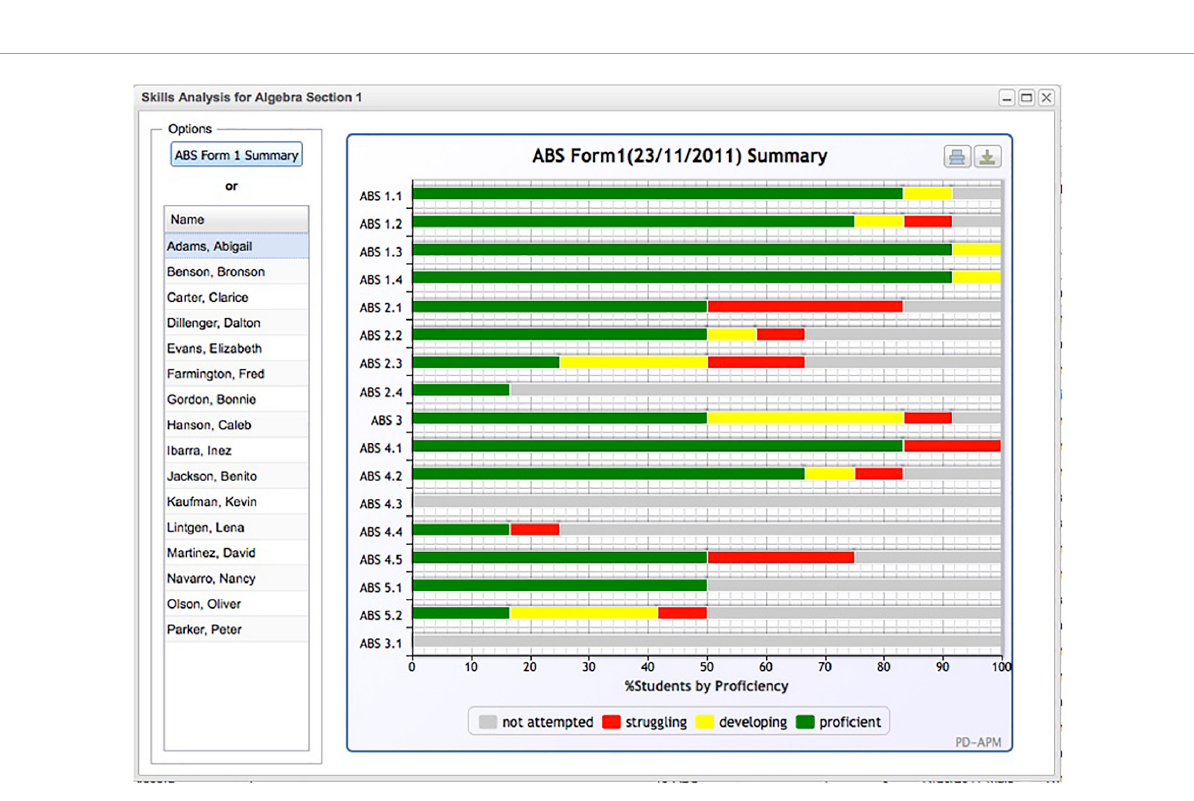
FIGURE3 Sample summary for student level of proficiency by type of